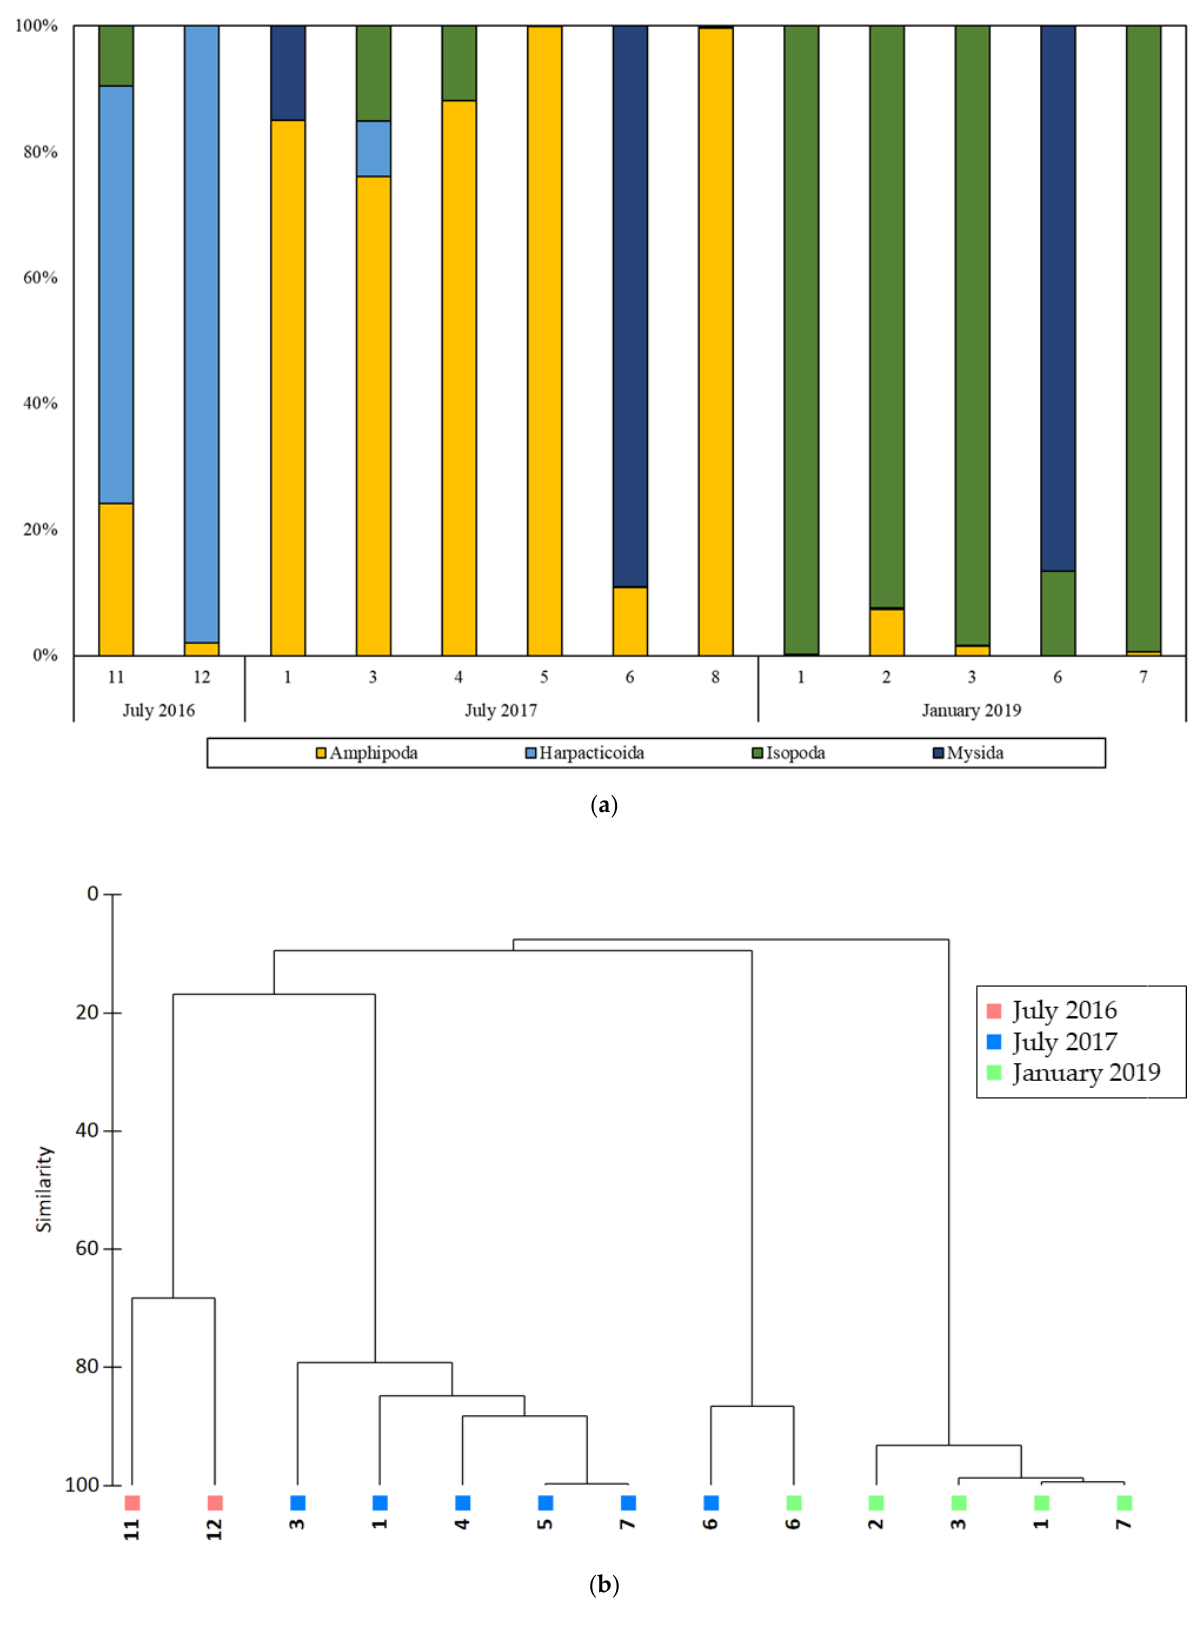
Figure 4. ( a ) The order-level taxonomic ratio of gut contents analyzed with COI primer. ( b ) Similarity analysis of gut contents by collecting period.